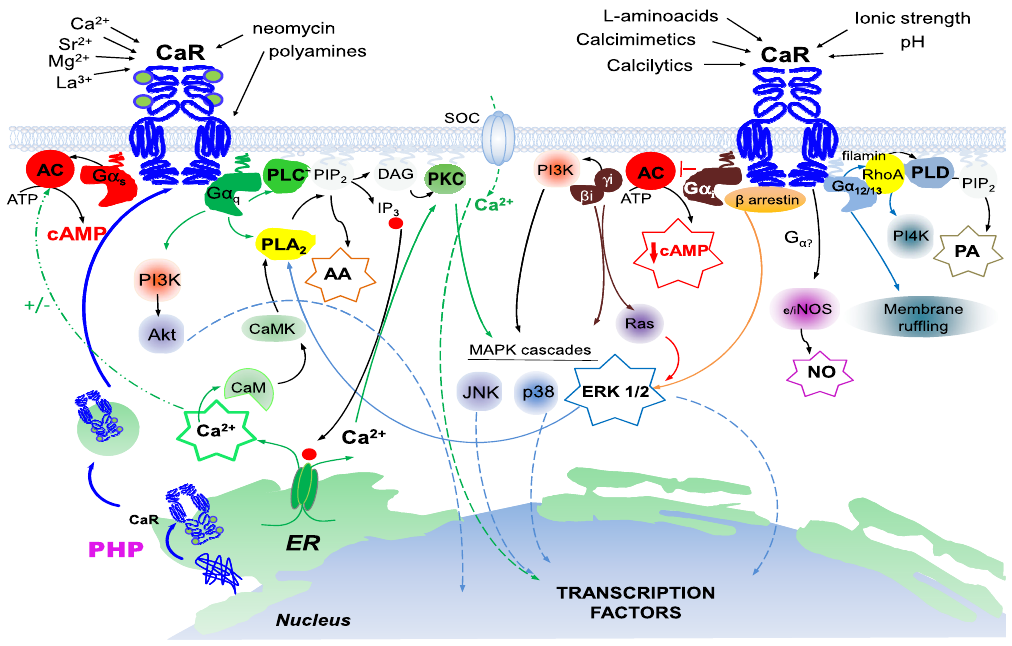
Figure 1. Signal transduction mediated by the extracellular calcium-sensing receptor (CaR). Schematic of the dimeric extracellular CaR at the plasma membrane. A complex network of intracellular transduction cascades is activated by numerous orthosteric agonists or allosteric modulators converging either on the bi-lobed venus-flytrap domain or on the seven transmembrane domain of the CaR. For clarity, two G-protein-coupled receptors (GPCRs) are shown; this is not meant to imply that the ligands depicted are linked preferentially to a particular intracellular signaling pathway, although see section in text on biased agonism. Abbreviations: AA, arachidonic acid; AC, adenylate cyclase; Akt, protein kinase B; ATP, adenosine triphosphate; CaM, calmodulin; CaMK, Ca 2+ /calmodulin-dependent protein kinase; cAMP, cyclic AMP; DAG, diacylglycerol; eNOS, endothelial nitric oxide synthase; ER, endoplasmic reticulum; ERK 1/2, extracellullar-signal- regulated kinase; G α , G α , G α , G α , α subunits of the s-, i-, q-, and 12/13-type heterotrimeric G-proteins, respectively; iNOS, inducible s i q 12/13 nitric oxide synthase; IP , inositol-1,4,5-trisphosphate; JNK, Jun amino-terminal kinase; MAPK, mitogen-activated protein kinase; MEK, MAPK 3 kinase; NO, nitric oxide; p38, p38 mitogen-activated protein kinase; PA, phosphatidic acid; PHP, pharmacoperones; PI3K, phosphatidylinositol 3-kinase; PI4K, phosphatidylinositol 4-kinase; PIP , phosphatidylinositol 4,5-bisphosphate; PKC, protein kinase C; PLA 2 PLC, phospholipase C; PLD, phospholipase D; RhoA, Ras homolog gene family, member A; SOC, store-operated Ca 2+